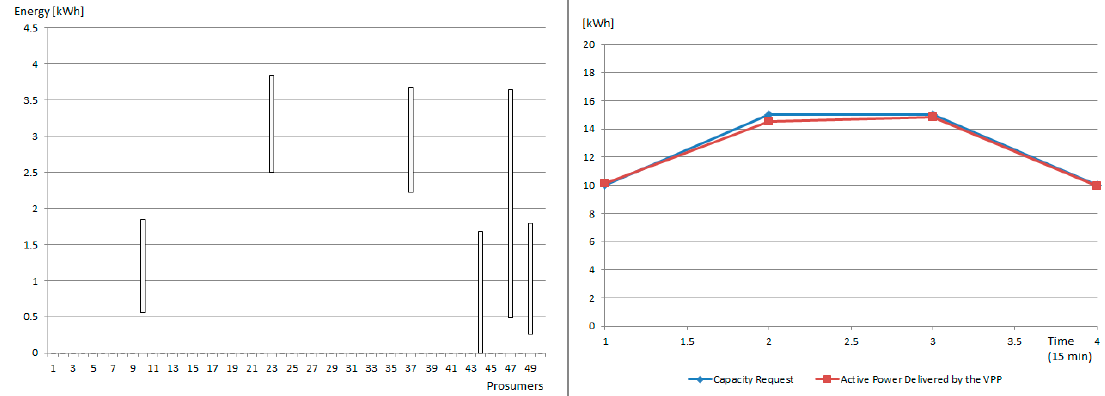
Figure 7. Prosumers in the VPP created in microgrid1: [LEFT] maximum and minimum energy consumption in the service interval and [RIGHT] Requested capacity vs. energy delivered by the VPP.